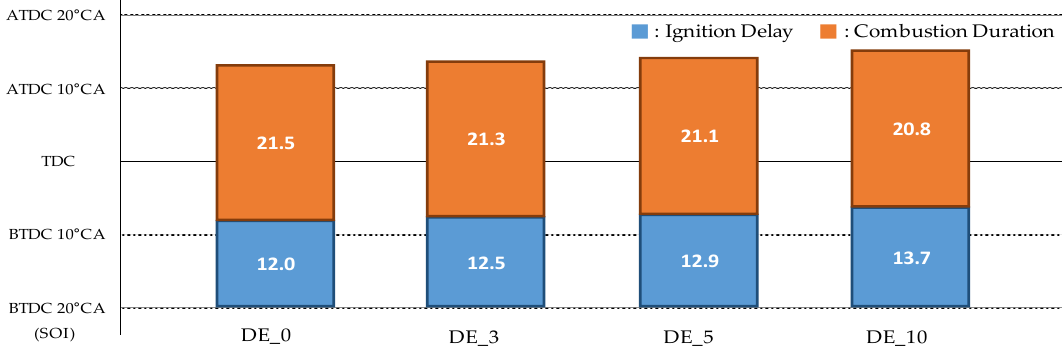
Figure 6. The ignition delay and combustion duration.